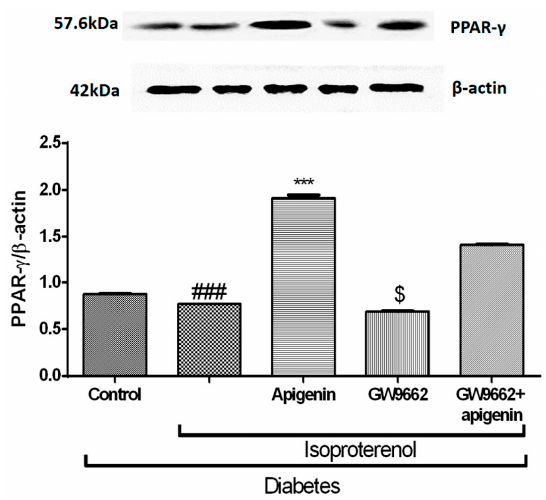
Figure 7. Effects of apigenin on PPAR- γ expression in STZ–isoproterenol-treated rats quantified by Western blot analysis. The data are expressed as mean ± SEM. The significance was determined by one-way ANOVA followed by the Bonferroni’s post hoc test: *** p < 0.001 compared to diabetic isoproterenol; ### p < 0.001 compared to diabetic control; $ p < 0.001 compared to diabetic isoproterenol + GW9662 + apigenin.